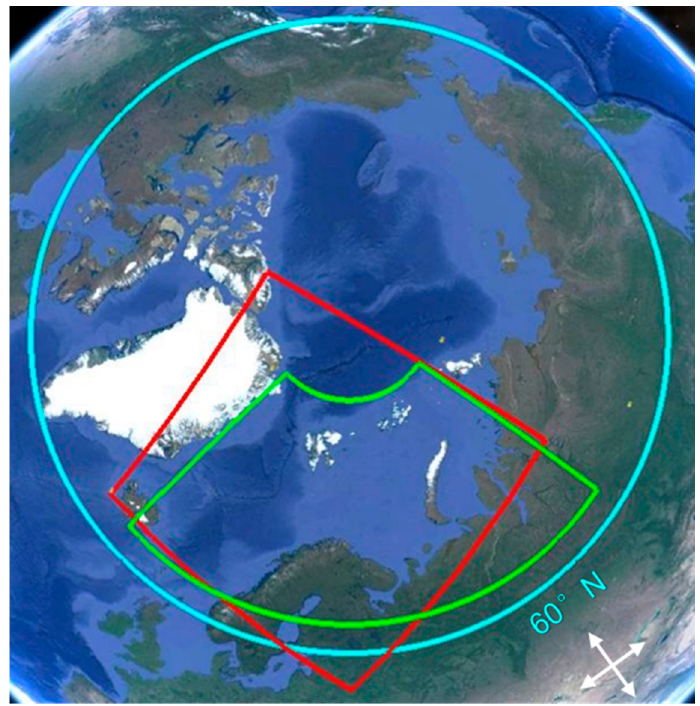
Figure 2. Computational domains. Blue—ICON-A6.5; green—ICON-A2; red—COSMO-CLM-A6.6. The initial data and boundary conditions for COSMO-CLM-A6.6 and ICON-A6.5 were obtained from the ICON global modelling system of the German weather service